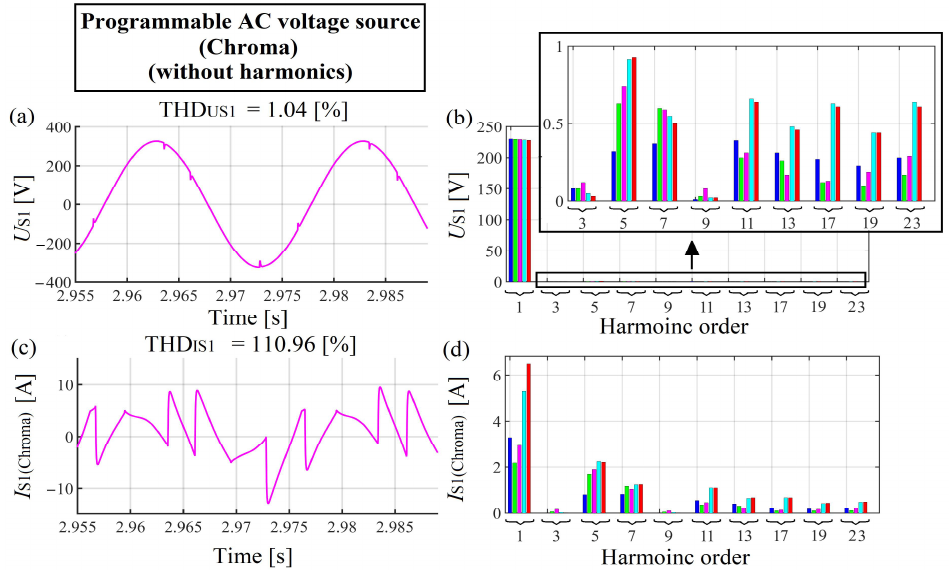
Figure 26. ( a ) PCC voltage waveform with the spectrum ( b ), ( c ) voltage source input current with the spectrum ( d ) (load and filter connected).